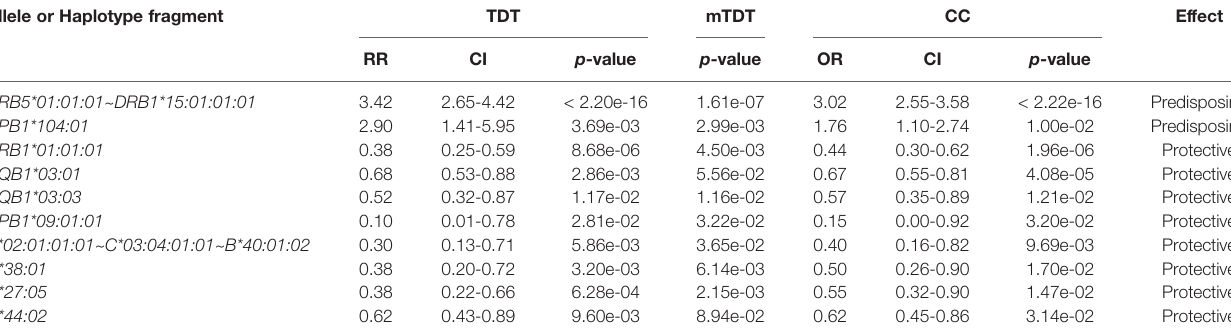
Table shows susceptible and protective associations with MS of HLA alleles and haplotype fragments examined by TDT, mTDT and CC. RR, CI and OR represent relative risk, con fi dence interval, and odds ratio, respectively. The TDT and mTDT results are obtained from 477 trio families. The CC results are generated from 477 cases and 2029 controls. Allele names for